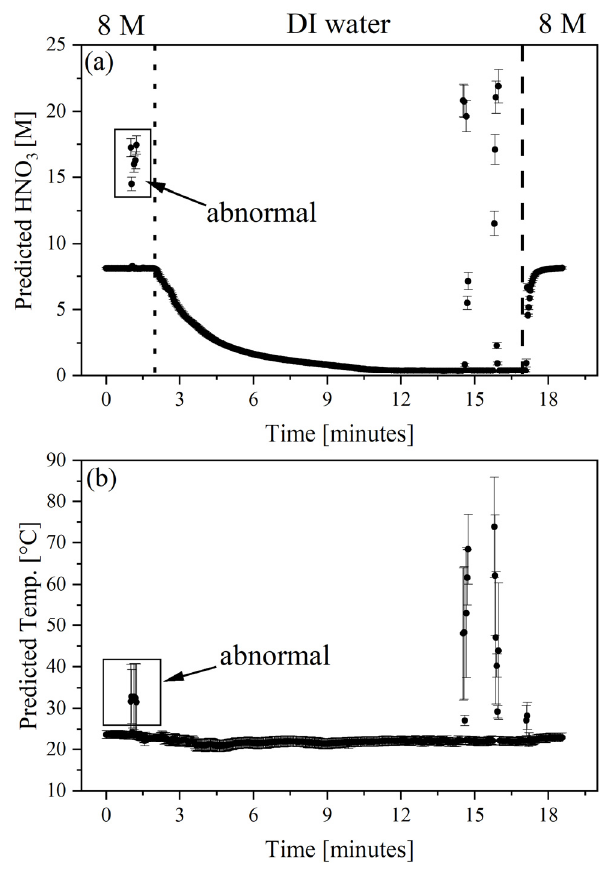
Figure 4. PLSR predicted HNO 3 ( a ) concentration and ( b ) temperature (Temp., °C) during gradient flow experiments. The vertical dotted line indicates when mixing with DI water was initiated, and the vertical dashed line indicates the switch back to 8 M HNO 3 . Several outliers owing to bubbles are noted.